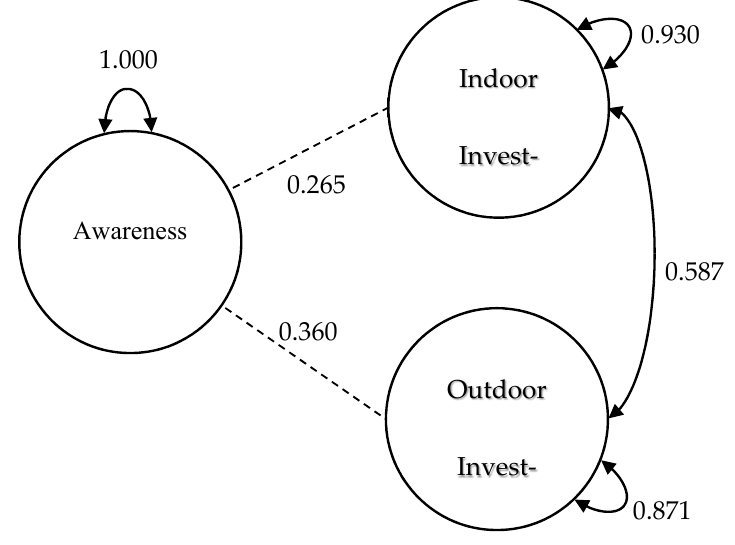
Figure 8. Model of owning water-saving appliances for indoor and outdoor usage regressed on awareness of water supplies for lawn and garden well owners ( n = 135).